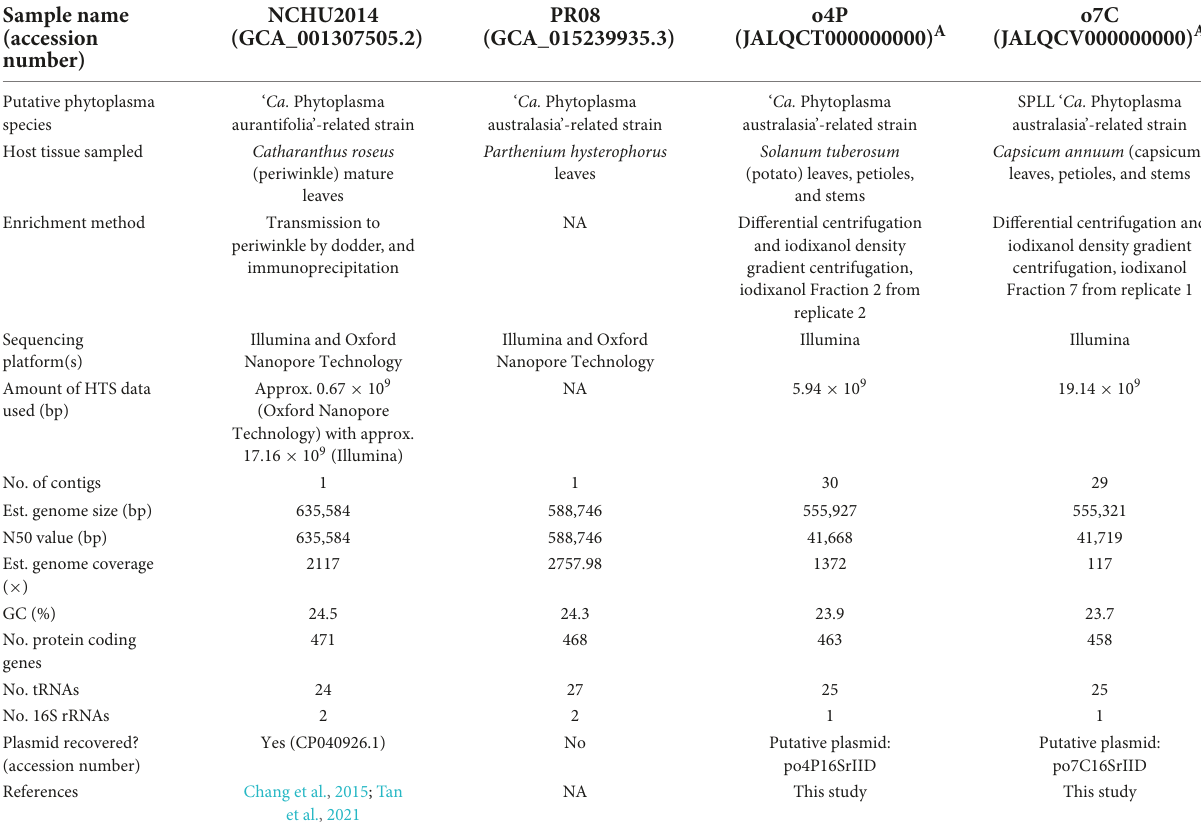
TABLE 2 Assembly details and statistics for phytoplasma genomes used as references in this study, including GenBank accession numbers, closest phytoplasma relative, sequencing details where available (tissue sampled, enrichment method, sequencing platforms, and sequencing depths), genome properties, plasmid accession